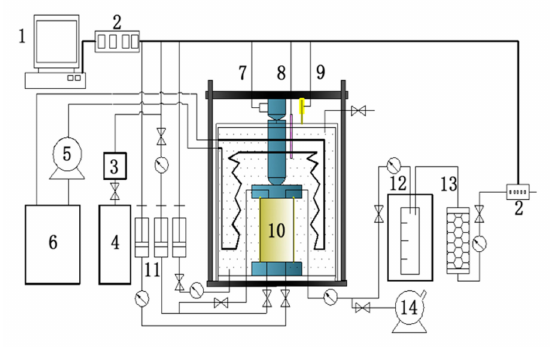
Figure 1. Schematic of the triaxial shear test apparatus: ( 1 ) computer; ( 2 ) data acquisition system;